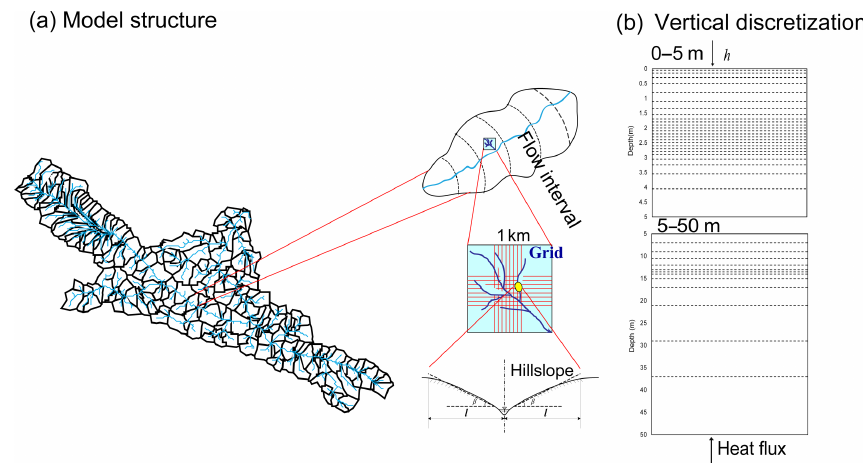
Figure 2. Model structure and vertical discretization of soil